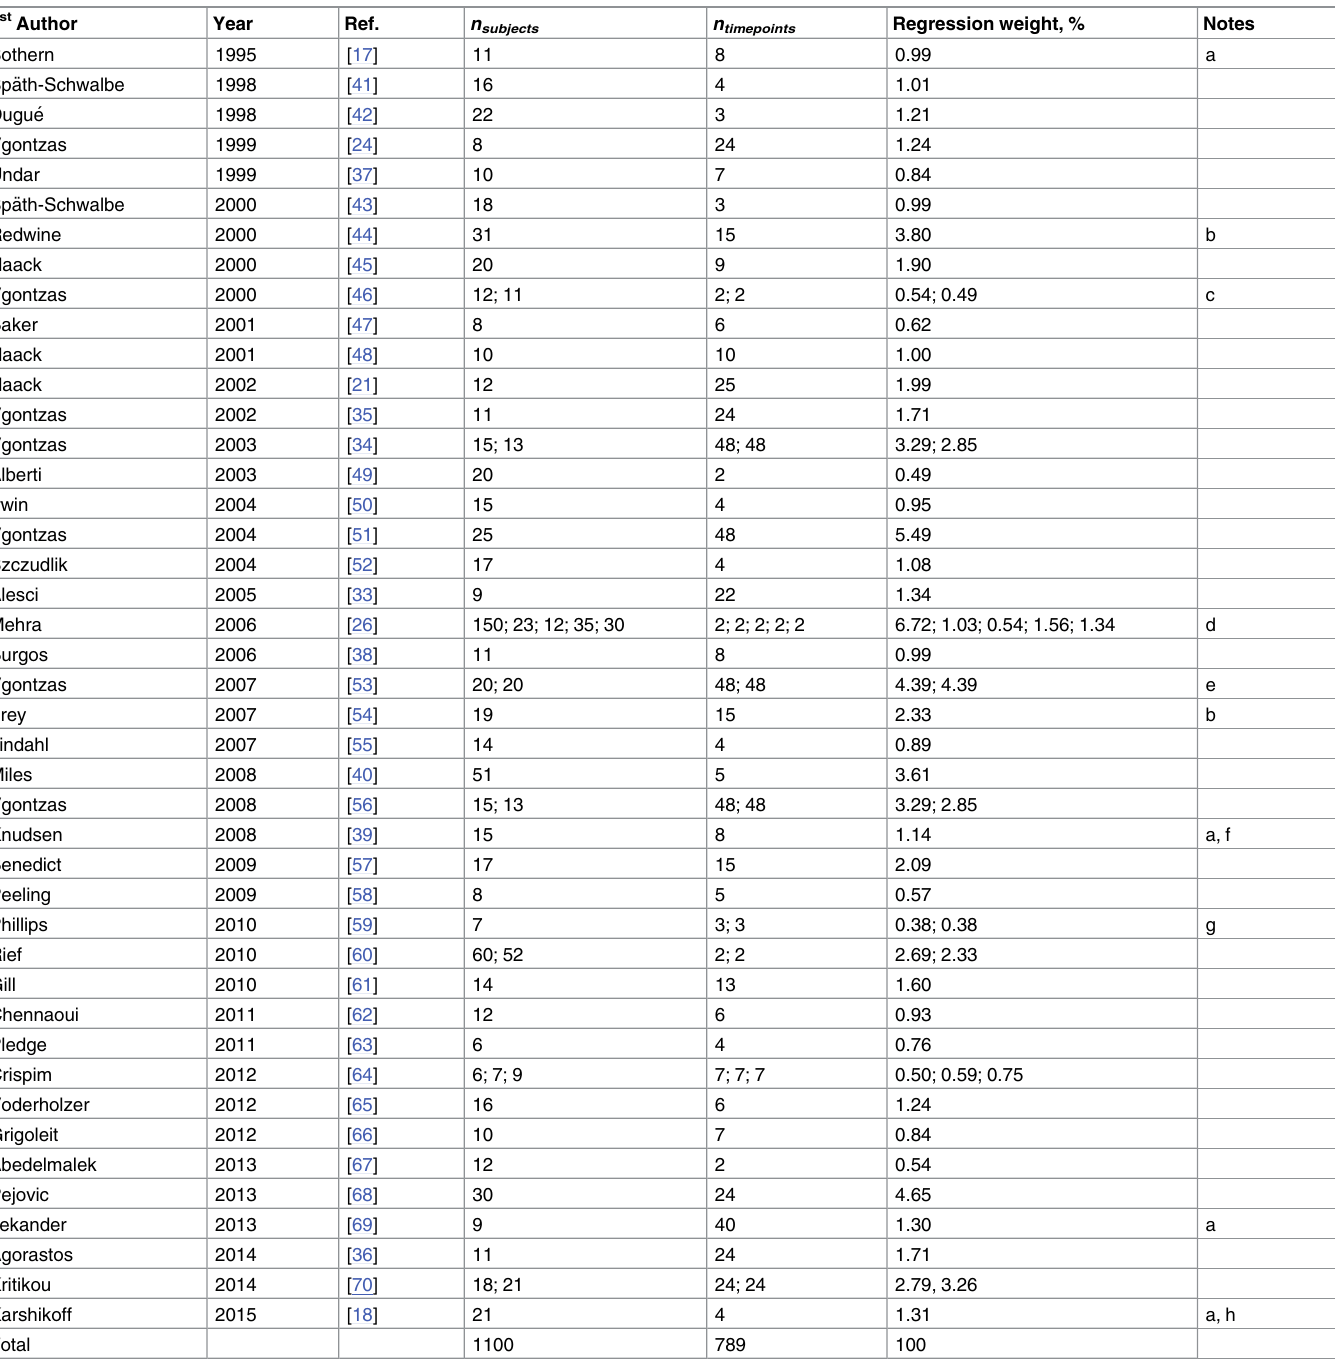
Table 1. Characteristics of included studies. Where studies reportedseveraldatasets, these are specified